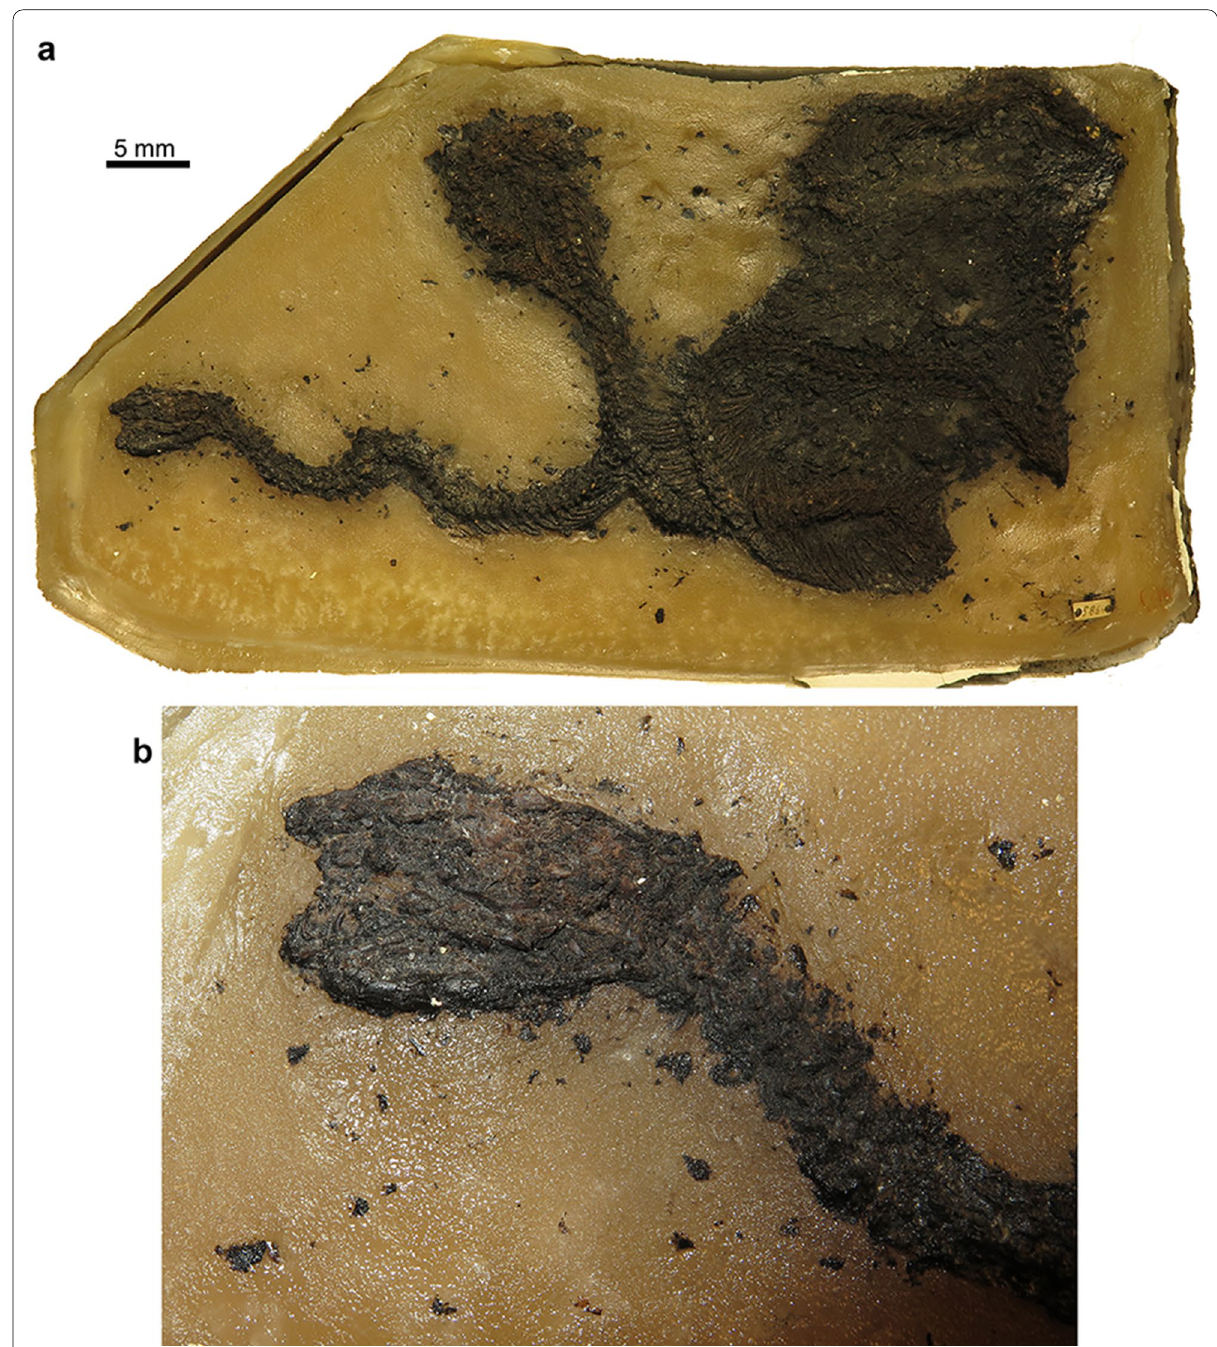
Fig. 106 Constrictores indet. from quarry Cecilie IV, Geiseltal: a articulated skeleton on a matrix (GMH Ce IV-5864-1933); b close up of the crushed skull of the same specimen. Specimen originally figured by Kuhn (1939a:pls. II.2 and